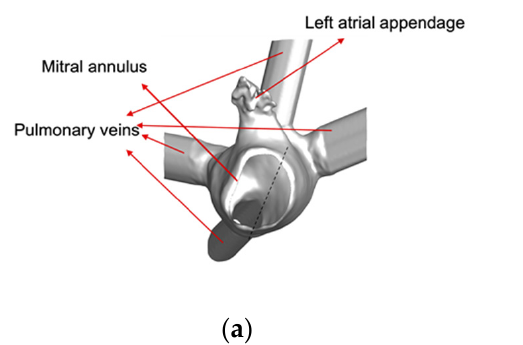
Figure 1. Left atrium model from CT scan: ( a ) bottom view; ( b ) side view.